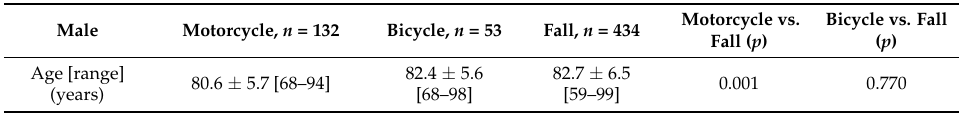
Table A2. Comparison of the mean age of motorcyclists and cyclists against incidence of those who had a fall among the female and male